Question: Which visualization type does this figure use?
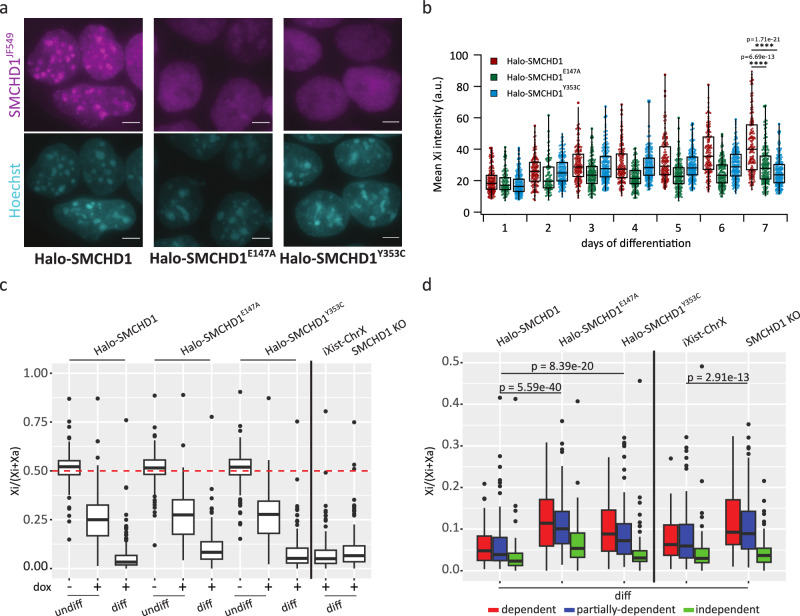
Answer: box